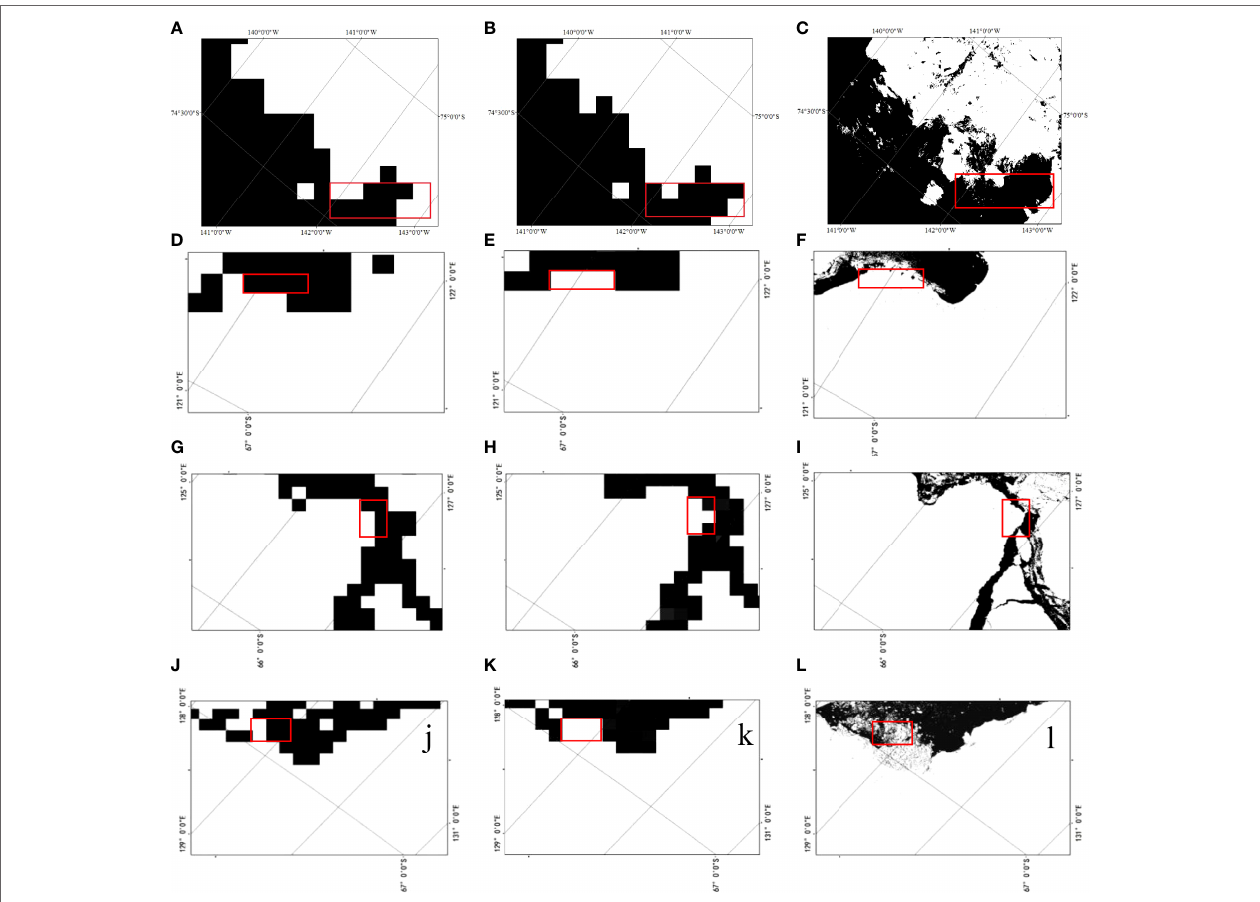
FIGURE 5 | (A) Sea ice distribution was obtained by the ASI algorithm on February 1, 2020 (B) Sea ice distribution was obtained by the improved ASI algorithm based on CGAN on February 1, 2020 (C) Sea ice distribution was obtained by the Landsat8 OLI-L1T data through the NDSI method on February 1, 2020. (D) Sea ice distribution was obtained by the ASI algorithm on October 16, 2019 (E) Sea ice distribution was obtained by the improved ASI algorithm based on CGAN on October 16, 2019 (F) Sea ice distribution was obtained by the Landsat8 OLI-L1T data through the NDSI method on October 16, 2019. (G) Sea ice distribution was obtained by the ASI algorithm on November 10, 2019 (H) Sea ice distribution was obtained by the improved ASI algorithm based on CGAN on November 10, 2019 (I) Sea ice distribution was obtained by the Landsat8 OLI-L1T data through the NDSI method on November 10, 2019. (J) Sea ice distribution was obtained by the ASI algorithm on March 6, 2020 (K) Sea ice distribution was obtained by the improved ASI algorithm based on CGAN on March 6, 2020 (L) Sea ice distribution was obtained by the Landsat8 OLI-L1T data through the NDSI method on March 6, 2020 (Projection: polar stereographic projection; The white area is sea ice, and the black area is sea